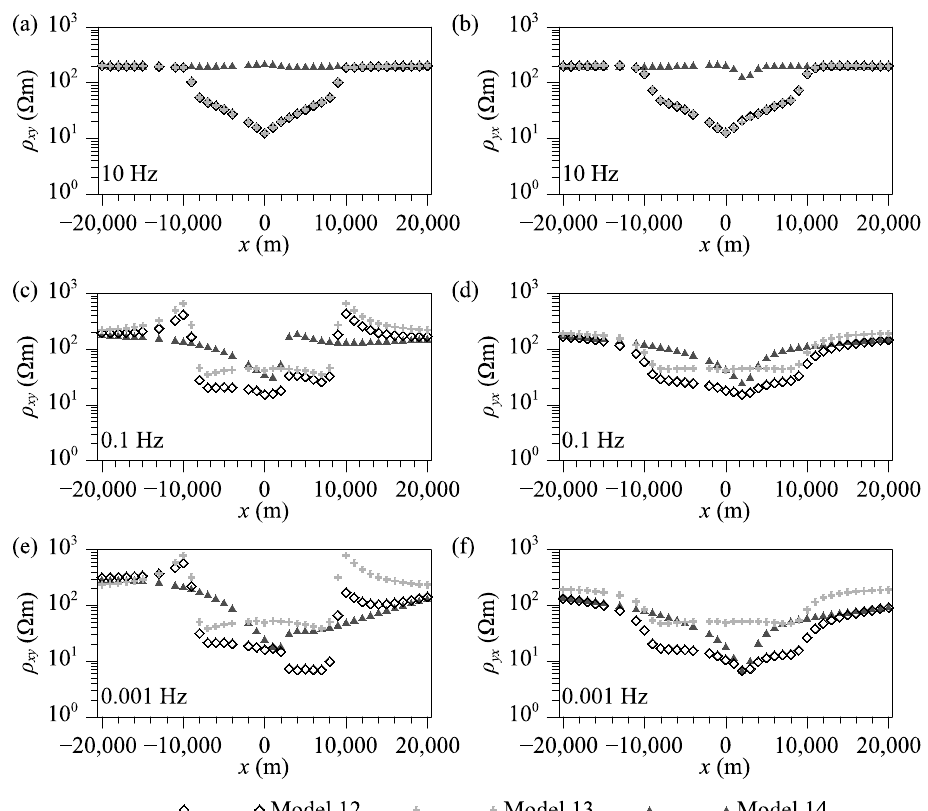
Figure 13. The tetrahedral grids of an HDR and partial melting system. ( a ) The bird’s-eye view of the conductive block. ( b ) The section view of y = 0 m.